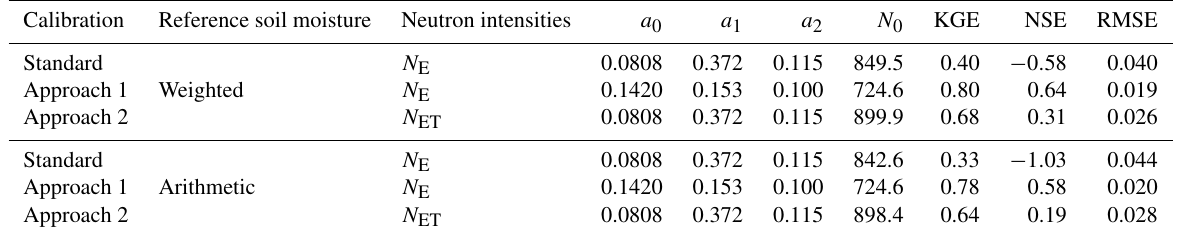
Table A1. Statistical goodness of fit when calibrating Eqs. (2)–(5) with (applying) the three different calibration approaches using reference soil moisture observations from TDR sensors with a higher noise and lower signal